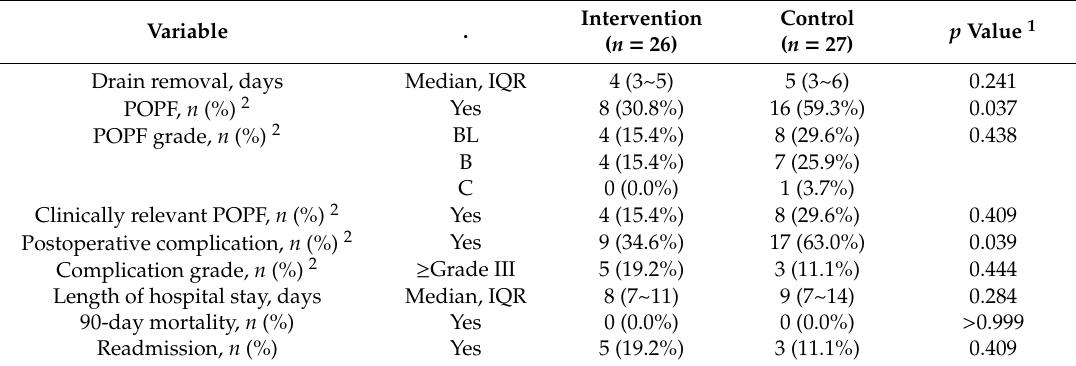
Table 2. Outcomes of postoperative pancreatic fistula and morbidities for all